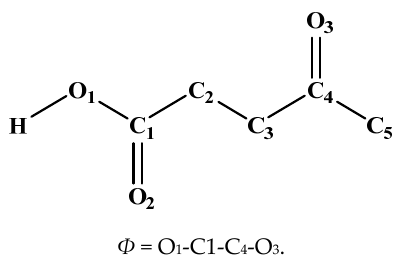
Figure 4. The dihedral angel formed between the carboxyl group and carbonyl group of levulinic acid.